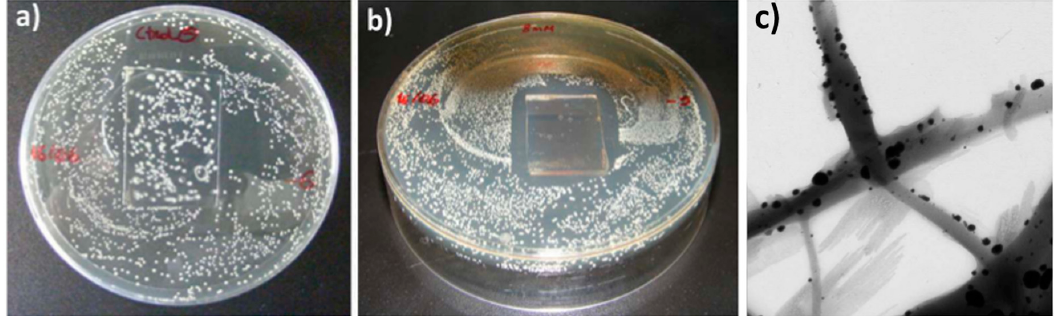
Figure 8. Bacteriological cultures of L. plantarum with two different samples: ( a ) reference sample with no silver nanoparticles and ( b ) silver loaded electrospun fiber mat. ( c ) TEM image of the AgNPs loaded electrospun fiber mat where it can be appreciated the AgNPs onto the electrospun nanofibers surface. Reproduced from [82] with permission; Copyright Elsevier 2012.